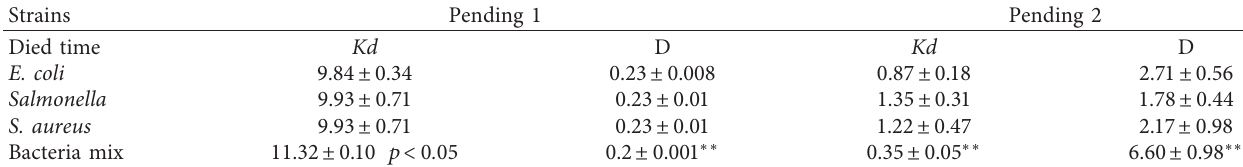
Table 1: Mean death constant ( ± SD) ∗ and time of death in seconds ( ± SD) ∗ of the different bacterial strains, in slopes 1 and 2. Strains